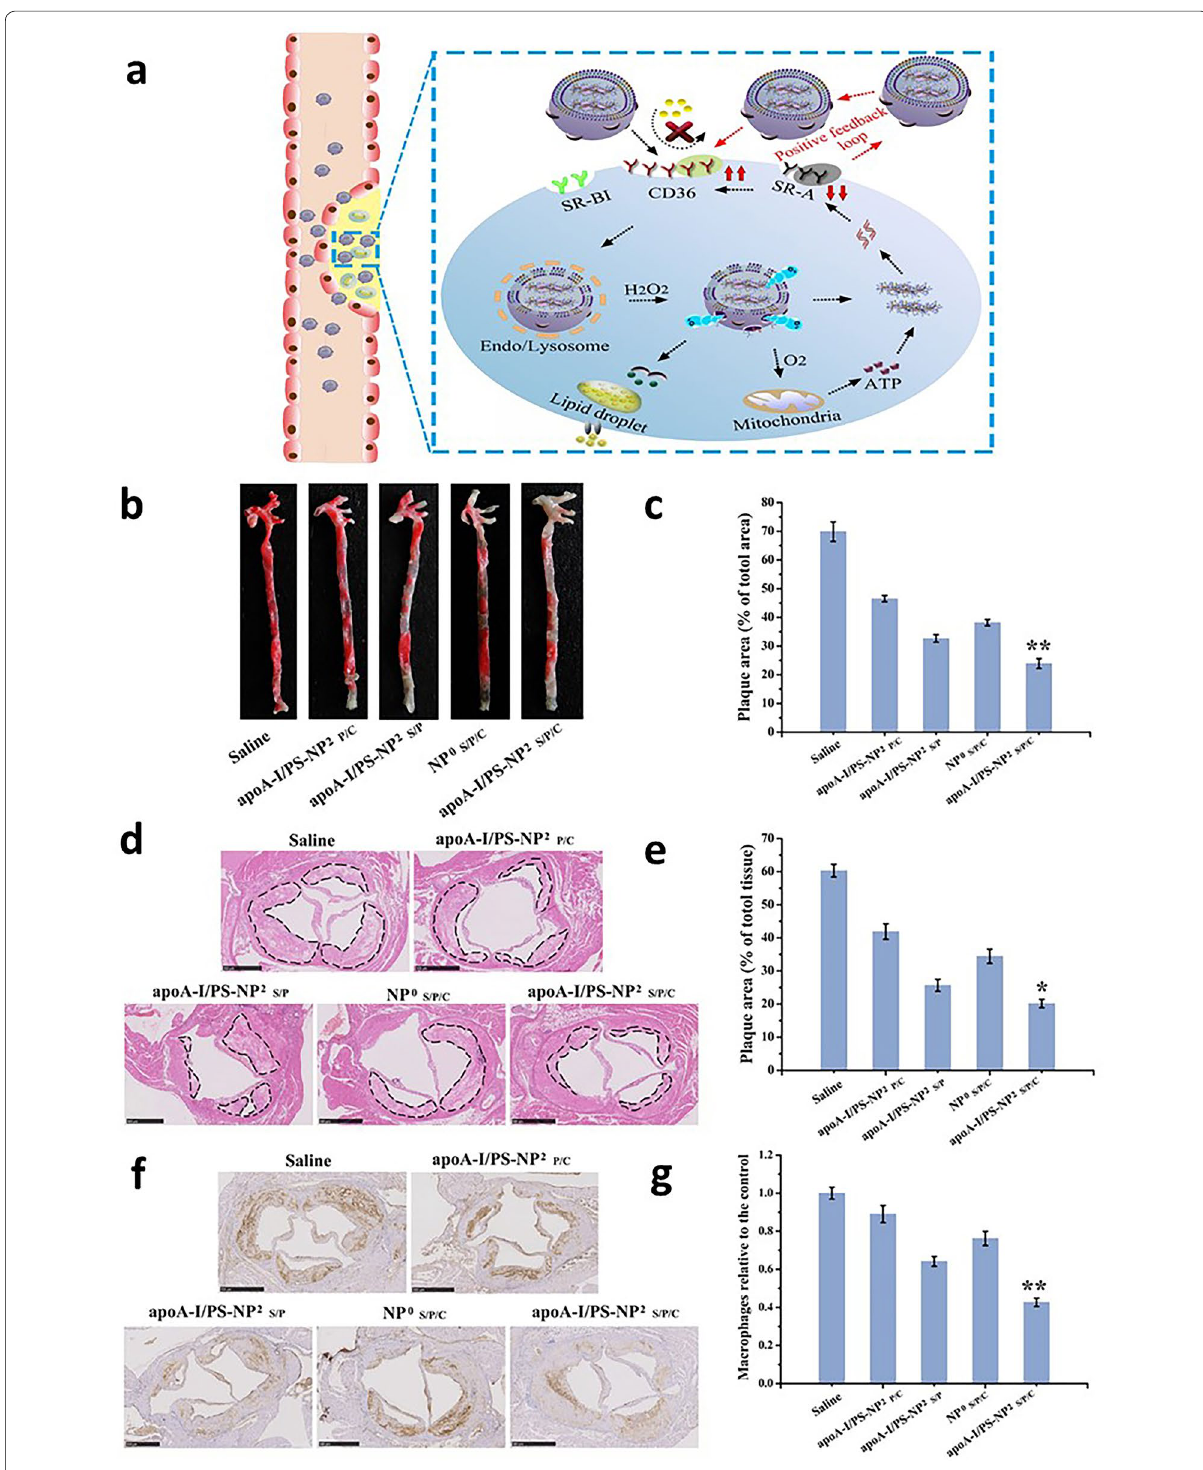
Fig. 2 a Schematic illustration of dual‑targeting biomimetic core–shell HDL mimicking NPs dynamically enhancing plaque targeting via a positive feedback loop and lowering intracellular lipid disposition. b Representative images and c quantitative data of aortic trees stained by oil red O. d Representative photographs and e quantitative analysis of plaque area based on H&E staining. f Representative images and g quantitative analysis of immunohistochemical staining of macrophages. Reproduce with permission [47]. Copyright 2019,